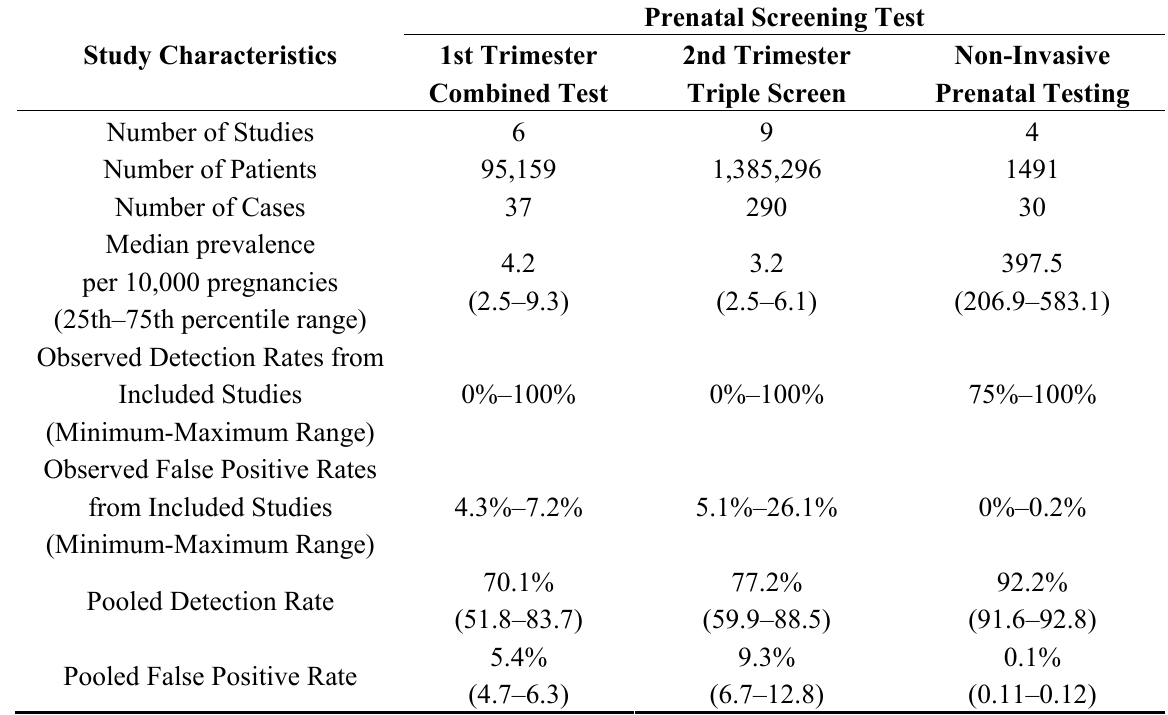
Table 4. Pooled results for